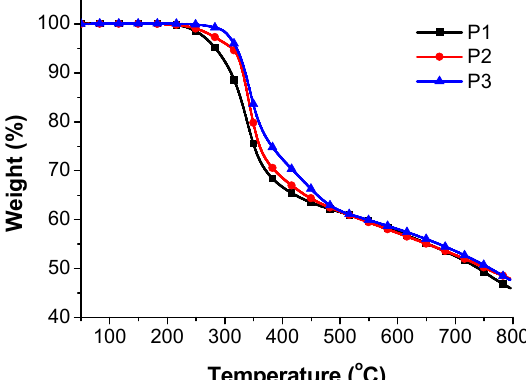
Figure 1. Thermogravimetric analysis (TGA) diagrams of the copolymers at a heating rate of 10 ◦ C / min under nitrogen